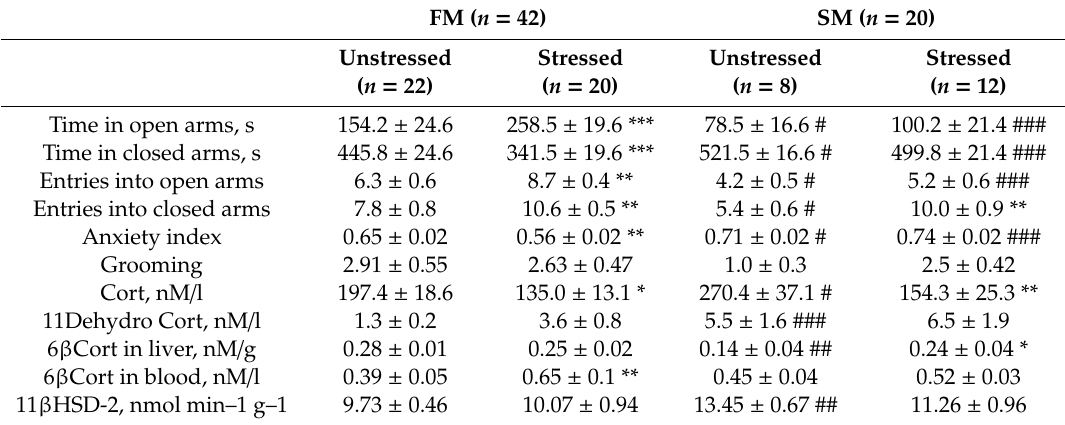
Table 1. Laboratory indicators and behavior of fast metabolism (FM) and slow metabolism (SM)